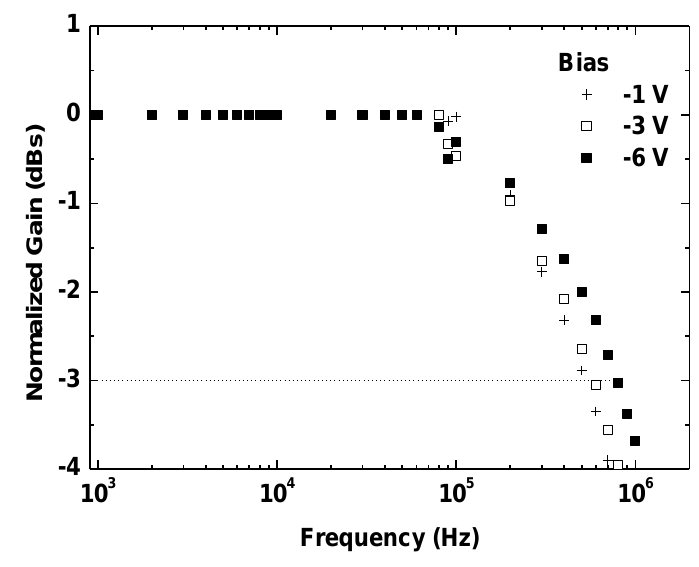
Figure 6. Modulation response of the OPD biased at −1 V, −3 V and −6 V under green-LED illumination. Frequency response was characterized with a 100-kHz lock-in amplifier setup and an electronic spectrum analyzer from 60 kHz